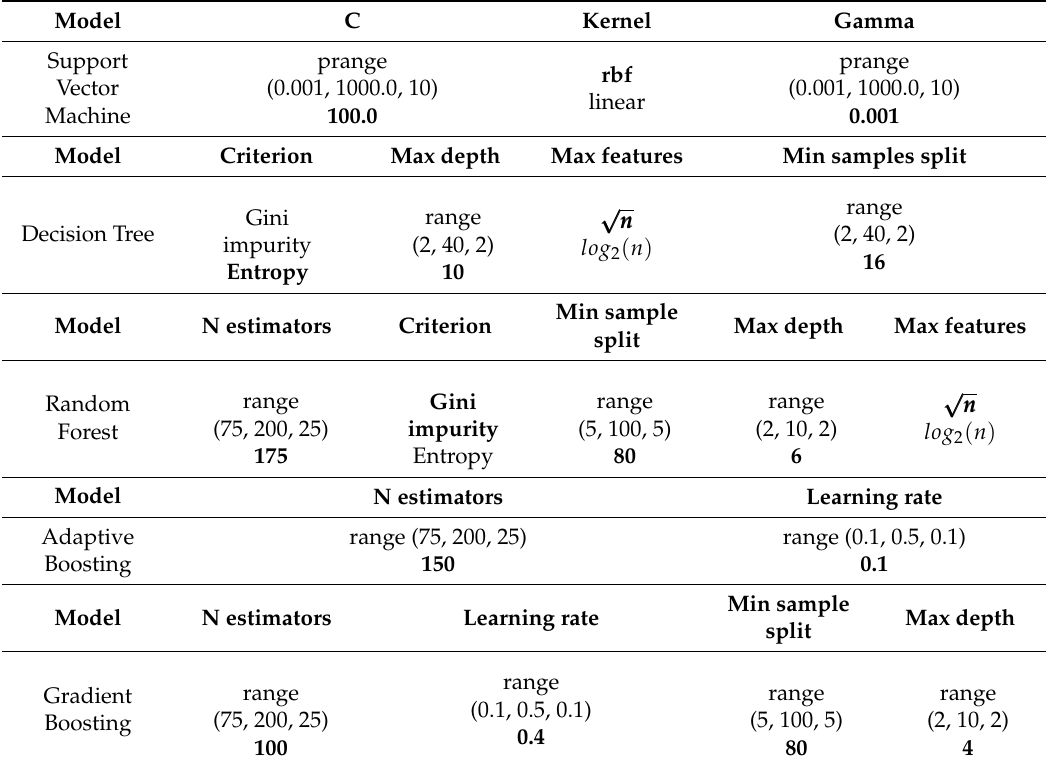
Table 5. Models’ grid